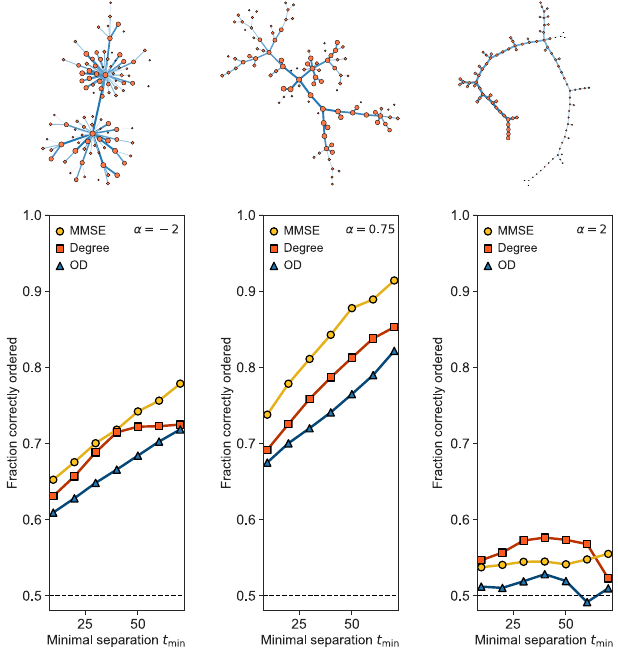
FIG. 7. Application to synthetic networks grown with a model that includes memory effects. (Top row) Single network instances with various values of the memory parameters α [43]. Edge thickness and node size encode age according to the ground truth (thicker and bigger equals older). Older nodes have a large probability of attracting new neighbors for the network shown on the left (memory parameter α ¼ − 2 ), while newer nodes are advantaged in the other two cases ( α ¼ 0 . 75 and 2). The negative effect of memory on attachment probability is strongest for the network shown on the right, with α ¼ 2 . We find that these ˆ b networks are best modeled with ¼ 1 and, from left to right, ˆ γ ¼ 1 . 76 ; 0 . 00 ; − 1 . 61 for the growth model (see Appendix A for details). The KS statistics D (cid:3) on our estimates of γ are D (cid:3) ¼ 0 . 044 , 0.055, 0.052, and the significance levels are P ð D > D (cid:3) Þ ¼ 0 . 47 , 0.45, 0.39, signaling a good fit (see Appen- dix A for details). The uncertainty scores are U ð G Þ ¼ 0 . 24 , 0.39, and 0.22 [see Eq. (8)]. (Bottom row) Fraction of edge pairs correctly ordered by the estimators, when separated by at least t time steps according to the ground truth, for the single min instances of the model shown in the top row. Ties are broken at random for the degree and OD estimators. MMSE estimators are calculated from n ¼ 200 000 Monte Carlo samples, using the estimated